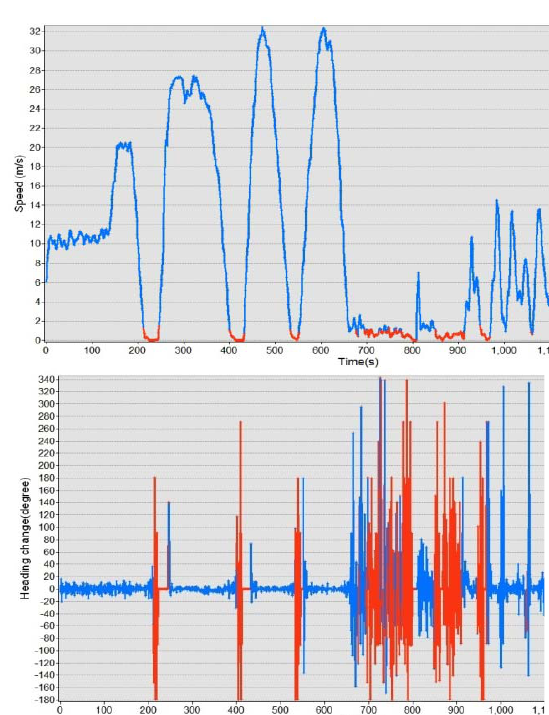
Figure 3. GPS-trace representing approximately 20 minutes of travelling divided into different individual segments in blue, and identified stops in red (top); corresponding heading changes magnitude